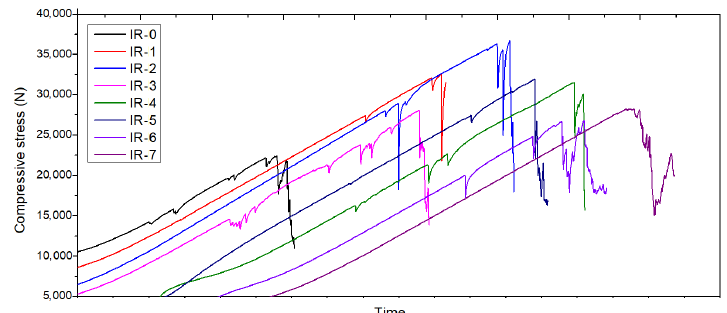
Figure 13. Typical compressive stresses of the IR- samples.